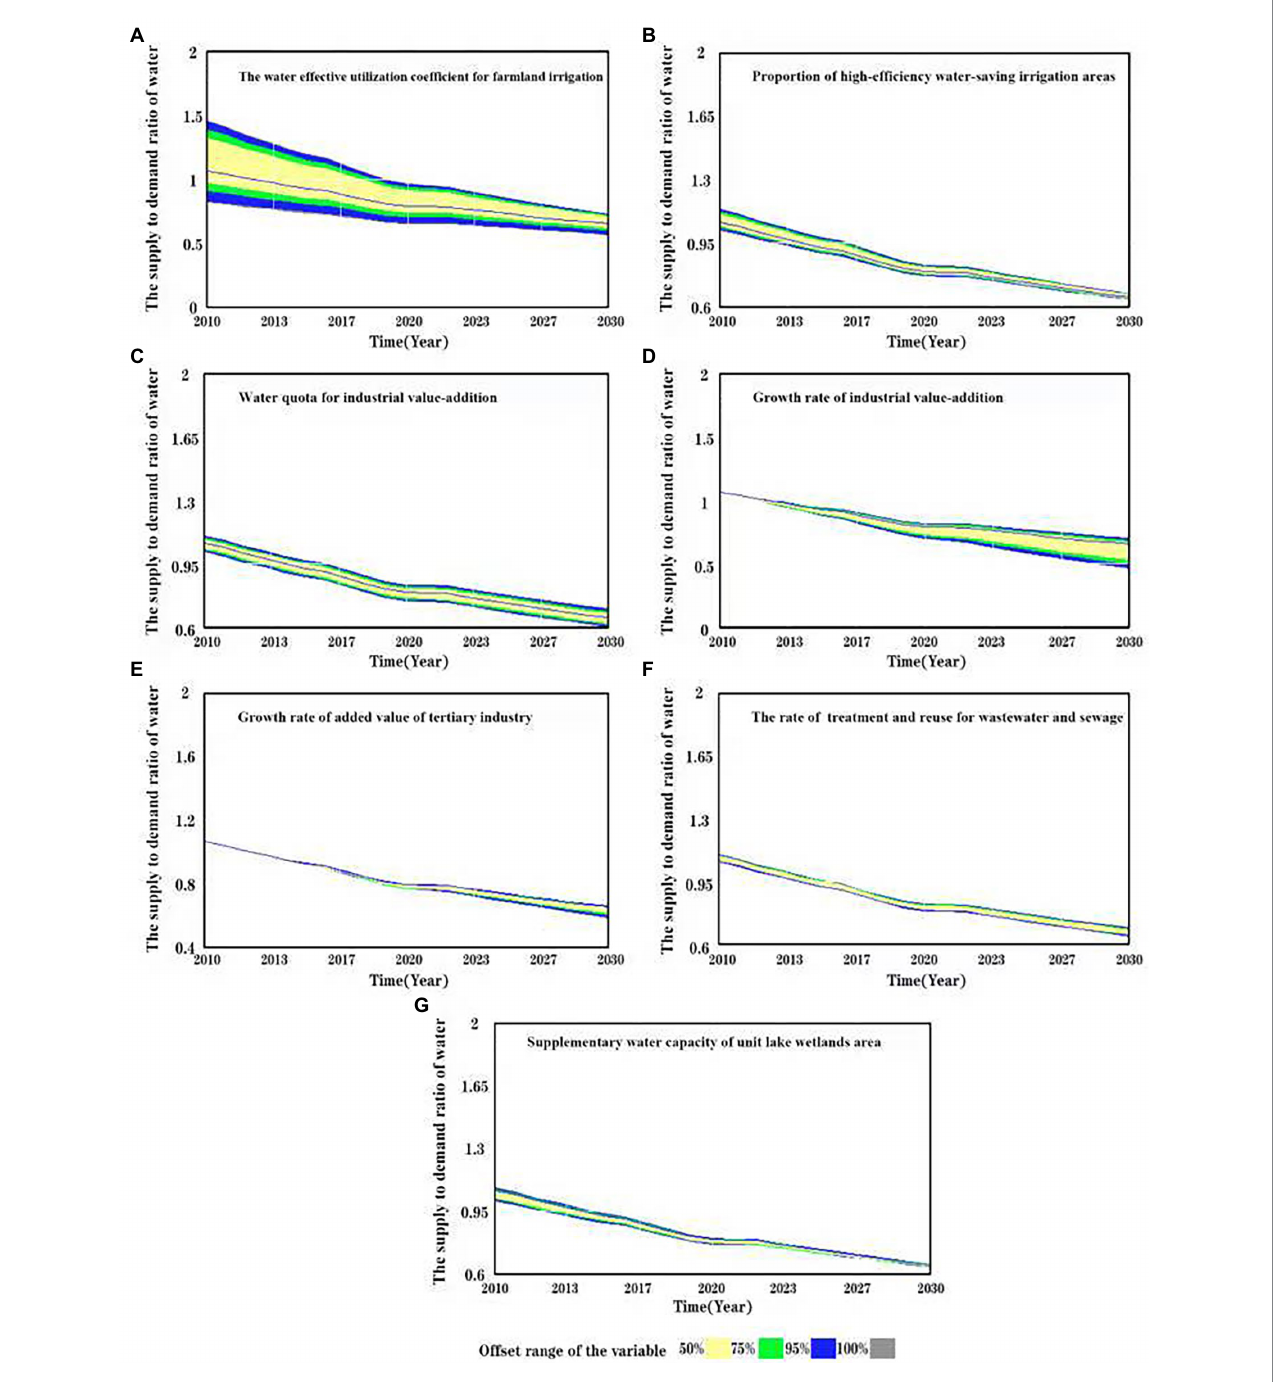
FIGURE 5 An analysis of the sensitivity to seven parameters on the supply to demand ratio of water. (A) The water effective utilization coefficient for farmland irrigation. (B) Proportion of high-efficiency water-saving irrigation areas. (C) Water quota for industrial value-addition. (D) Growth rate of industrial value- addition. (E) Growth rate of added value of tertiary industry. (F) The rate of treatment and reuse for wastewater and sewage. (G) Supplementary water capacity of unit lake wetlands